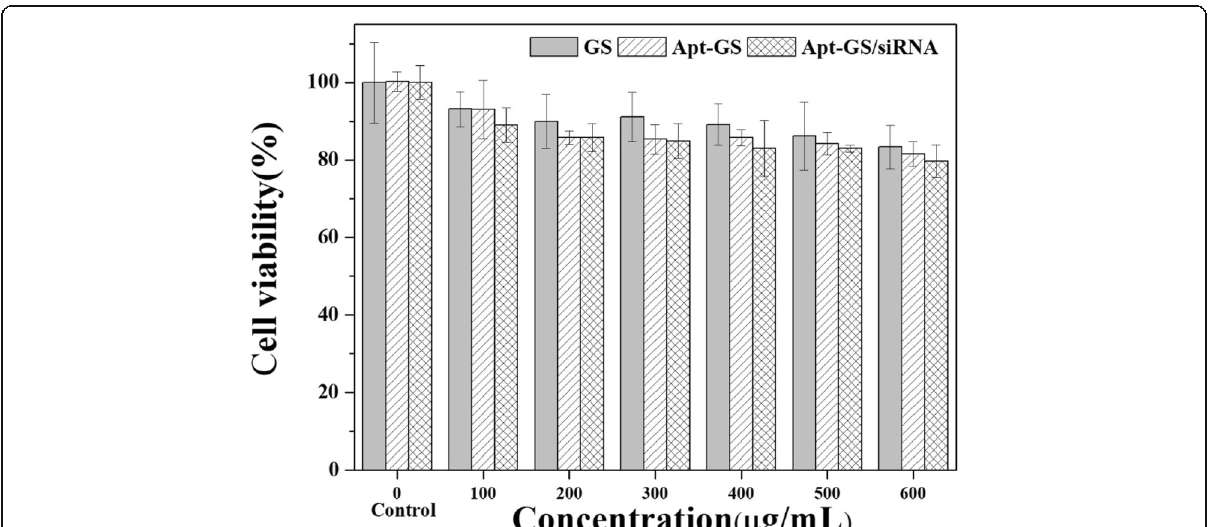
Fig. 4 Cell viability of A549 cells with GS, Apt-GS, and Apt-GS/siRNA nanogels of various concentrations determined by MTT assay